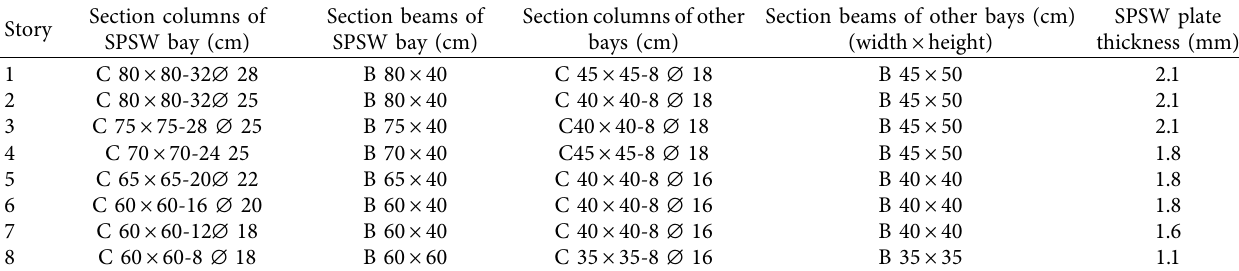
Table 3: Properties of designed beams, columns, and steel plate shear walls of 8-story model.